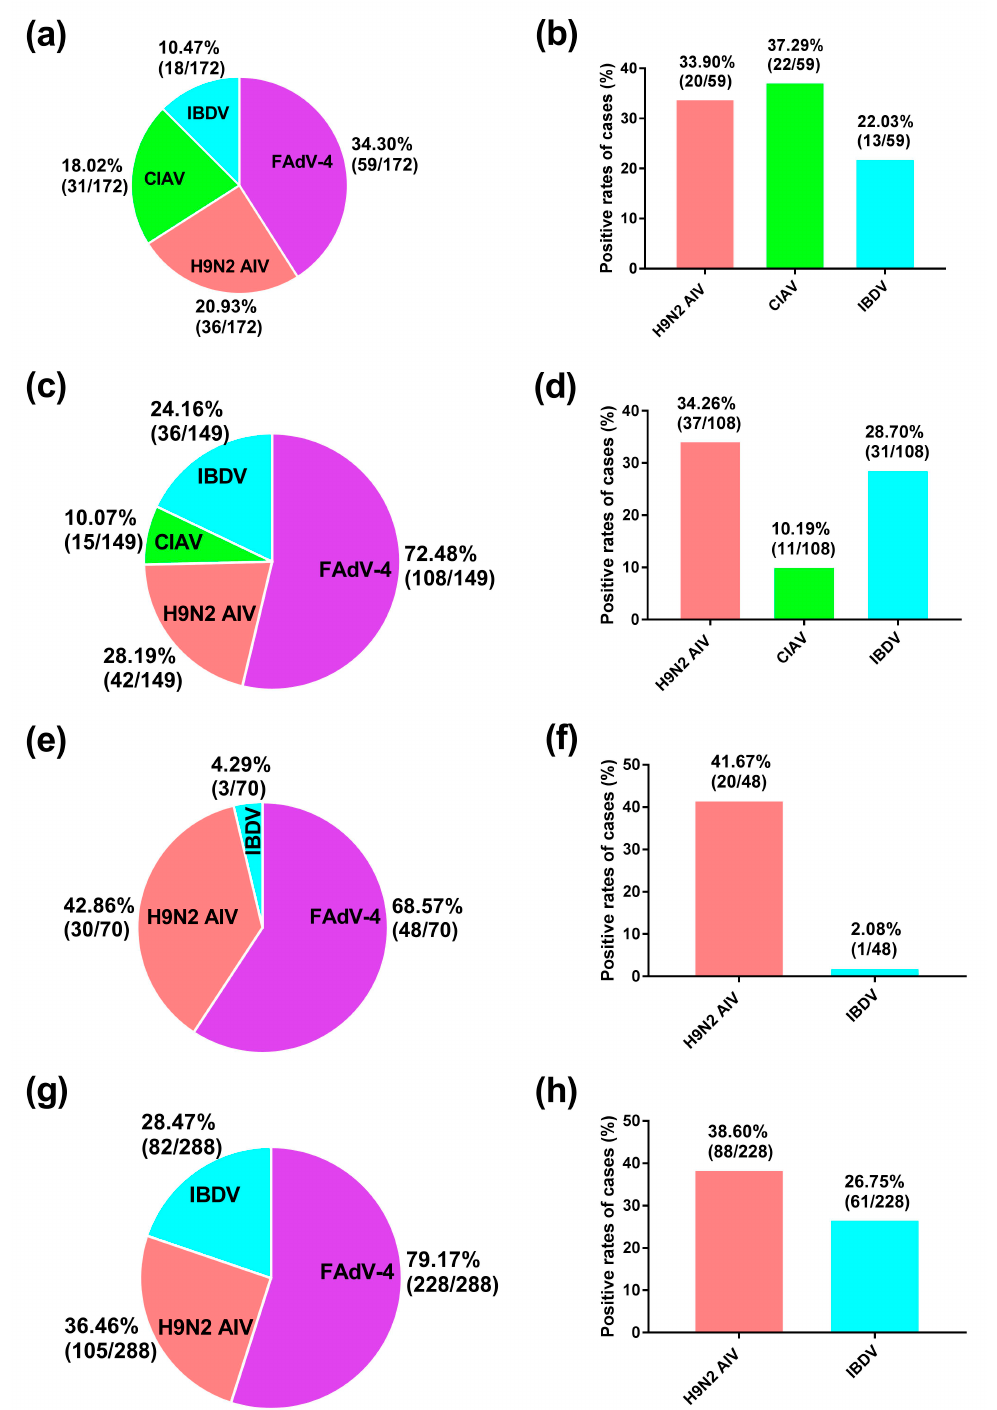
Figure 2. Co-infection by other viruses and FAdV-4 in tested samples. Note: ( a , c , e , g ) Pie charts showing the rates of infection of FAdV-4, H9N2 AIV, CIAV, and IBDV in the total population of the sampled fowl ( n = 679) sub-grouped by species and farming purpose as breeder chickens ( a ), commercial chickens ( c ), breeder ducks ( e ), and commercial ducks ( g ). ( b , d , f , h ) Co-infection rates for the 443 FAdV-4-infected sample animals with H9N2 AIV, CIAV (chickens only), and IBDV. Abbreviations: CIAV: chicken infectious anemia virus; FAdV-4: fowl adenovirus serotype 4; H9N2 AIV: H9N2 avian influenza virus; IBDV: infectious bursal disease virus.